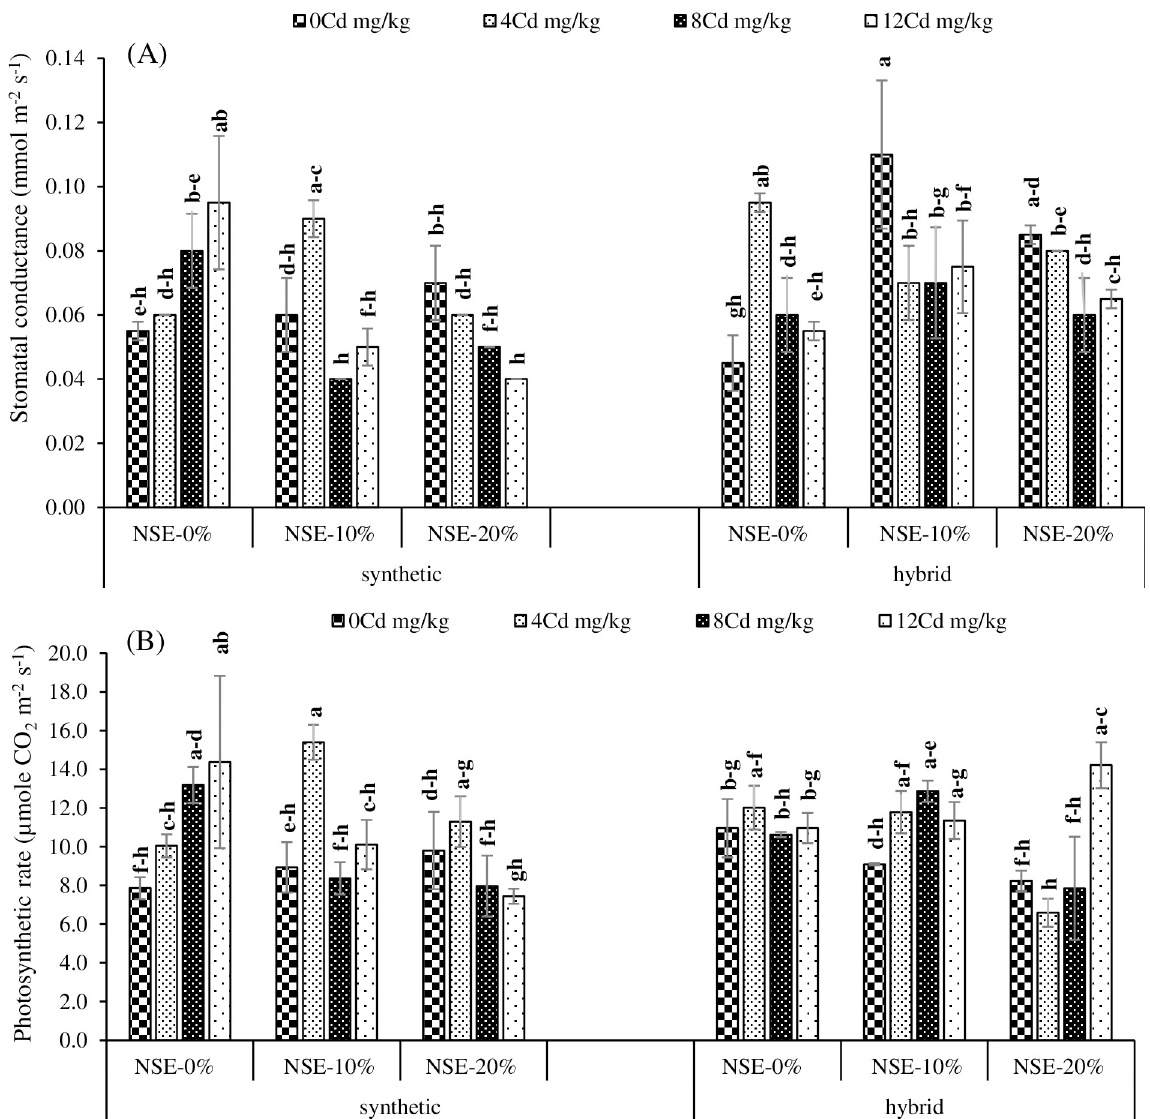
Fig 1. Effect of different concentrations of Nigella sativa seed extracts on stomatal conductance (A) and photosynthesis rate (B) ± standard errors on maize genotypes grown under various cadmium concentrations. Means sharing the same case letter for a parameter did not differ significantly from each other at p > 0.05. Here, NSE = N . sativa seed extract; DAS = days after sowing.